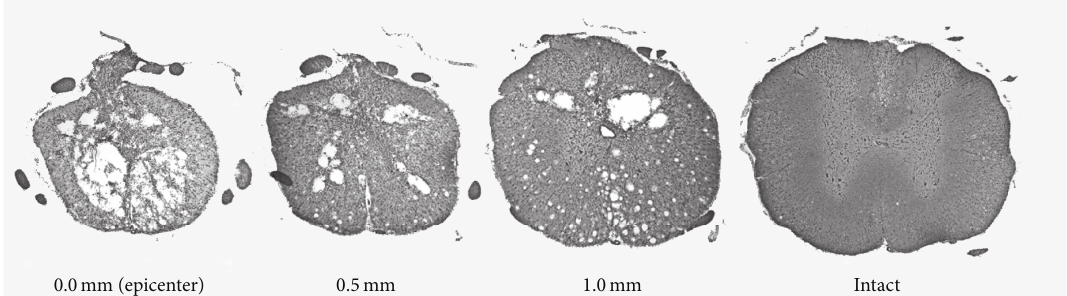
Figure 7: Representative spinal cord segments. Histological assessment did not reveal any differences between groups when analyzing total white or gray matter from the epicenter to 1.0 mm rostrally or when further subdividing the sections into areas of ventral and ventral lateral funiculi (ANOVA: nontrain 𝑛 = 7 ; train 𝑛 = 13 ; forelimb 𝑛 = 9